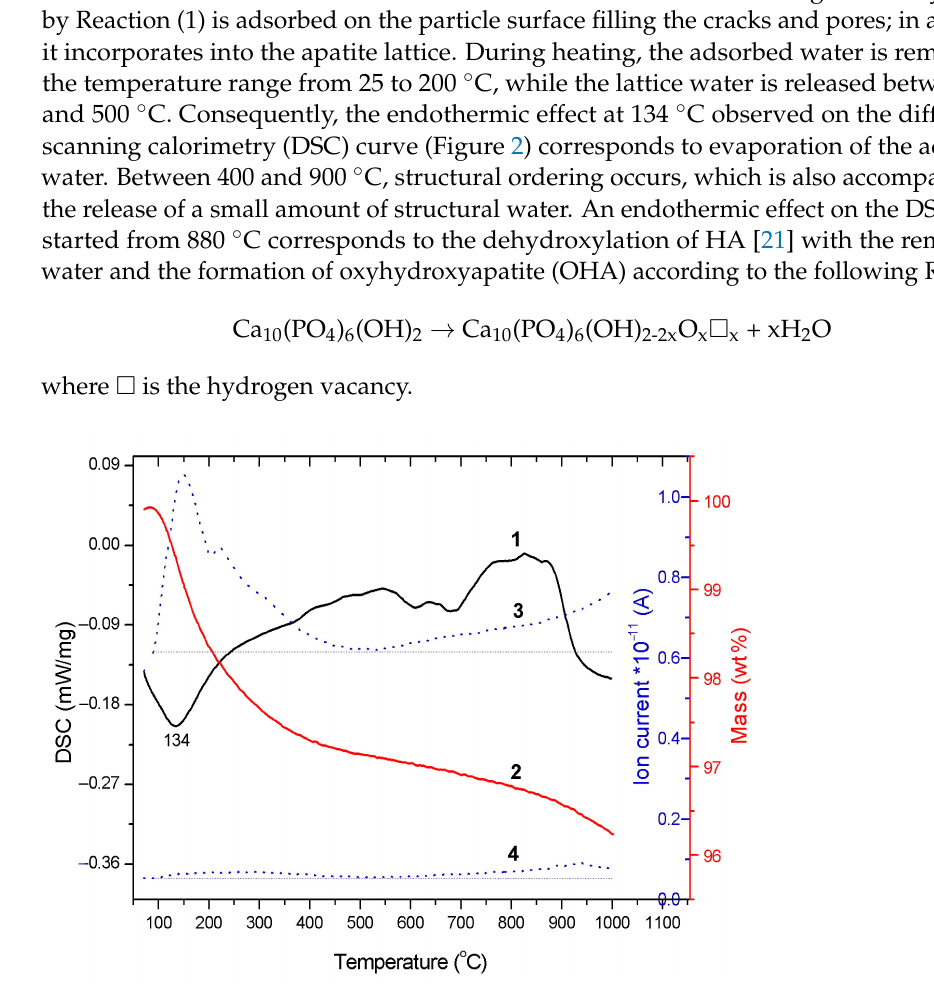
Figure 2. Thermal analysis of the as-synthesized HA powder: 1, differential scanning calorimetry; 2, weight loss; 3, evolved water; 4, evolved carbon dioxide.